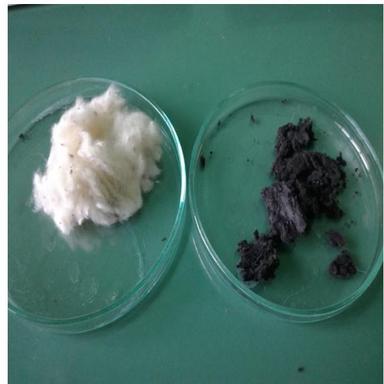
The raw (the left image feature) and carbonized (the right image feature) Poplar fluff.